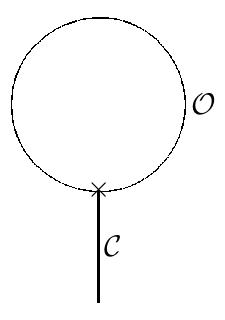
Figure 4 . A contribution to the annulus amplitude with one external closed